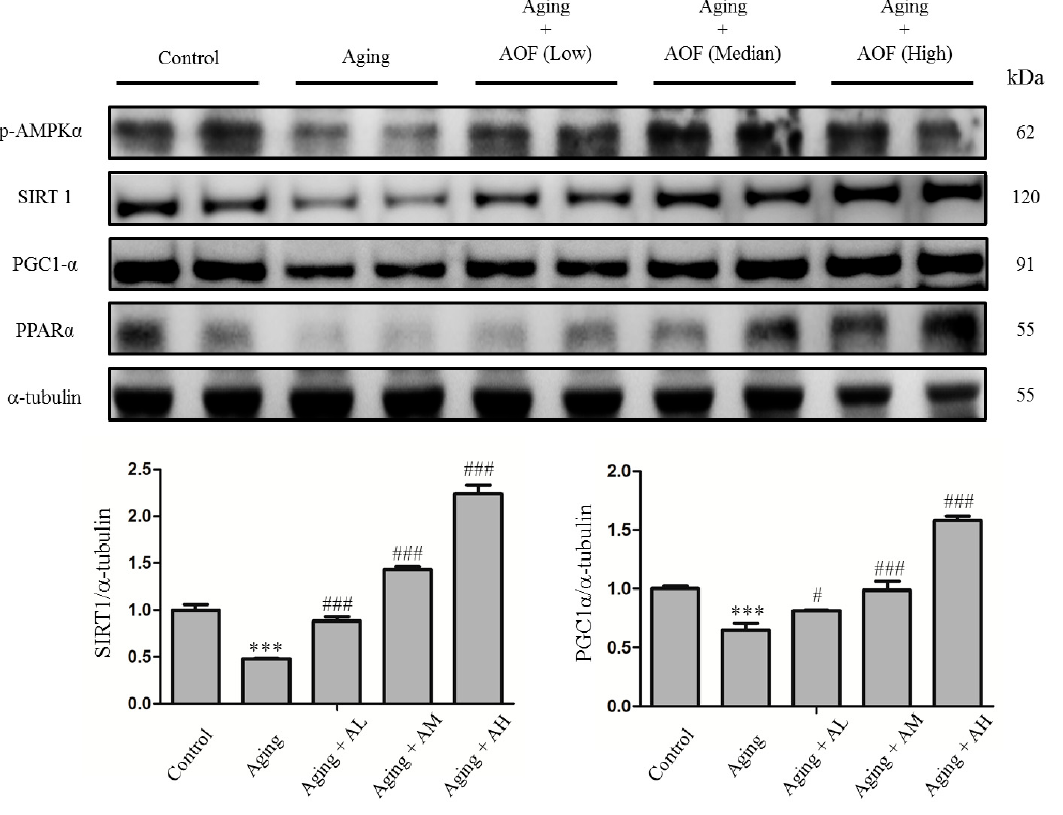
Figure 6. Effect of AOF on D -galactose-induced Sirtuin 1 (SIRT1) pathway related protein in SD rat cardiac tissue. The total protein of SD rat cardiac tissue extracts was separated by 12% SDS-PAGE, transferred to PVDF membranes, and immunoblotted with antibodies against p-AMPK, SIRT1, PGC-1 α and PPAR α antibody to detect survival markers expression. Equal loading was assessed with an anti- α -tubulin antibody. These blots were quantified by densitometry. α -tubulin served as a loading control. Data are presented as means ± S.D. Bars indicate averages, *** p < 0.001, represent a significant difference versus the control; # p < 0.05; ### p < 0.001, represent a significant difference versus the aging group. n = three independent experiments for each data point.